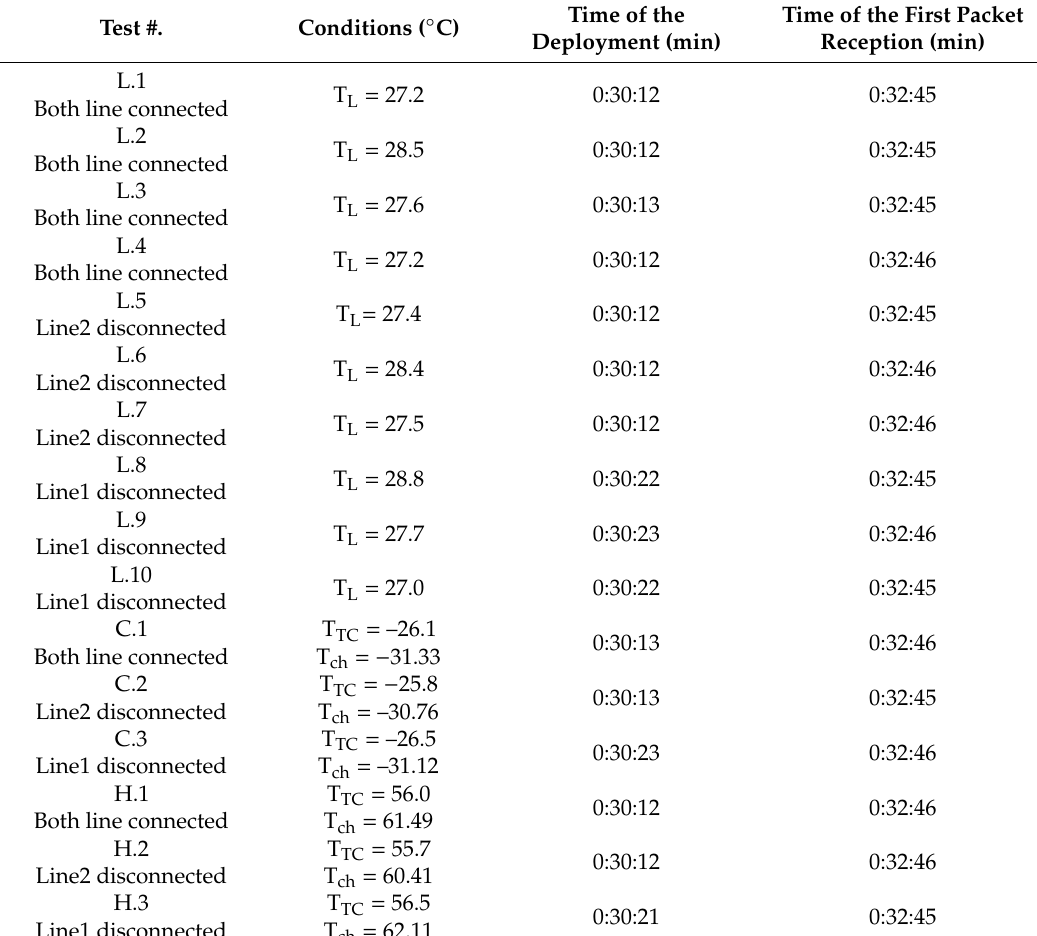
Table 3. Results of the test campaign on the antenna deployment